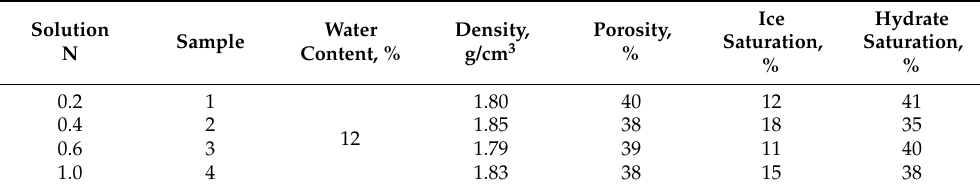
Table 4. Frozen hydrate-saturated sand samples before interaction with a NaCl solution of different concentrations.